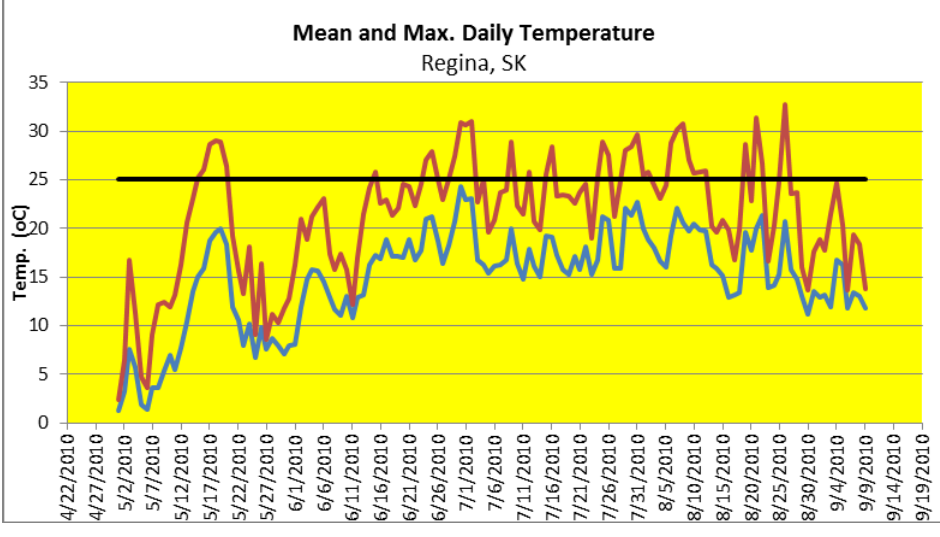
Figure 1. Daily average and maximum temperature by city. Summer